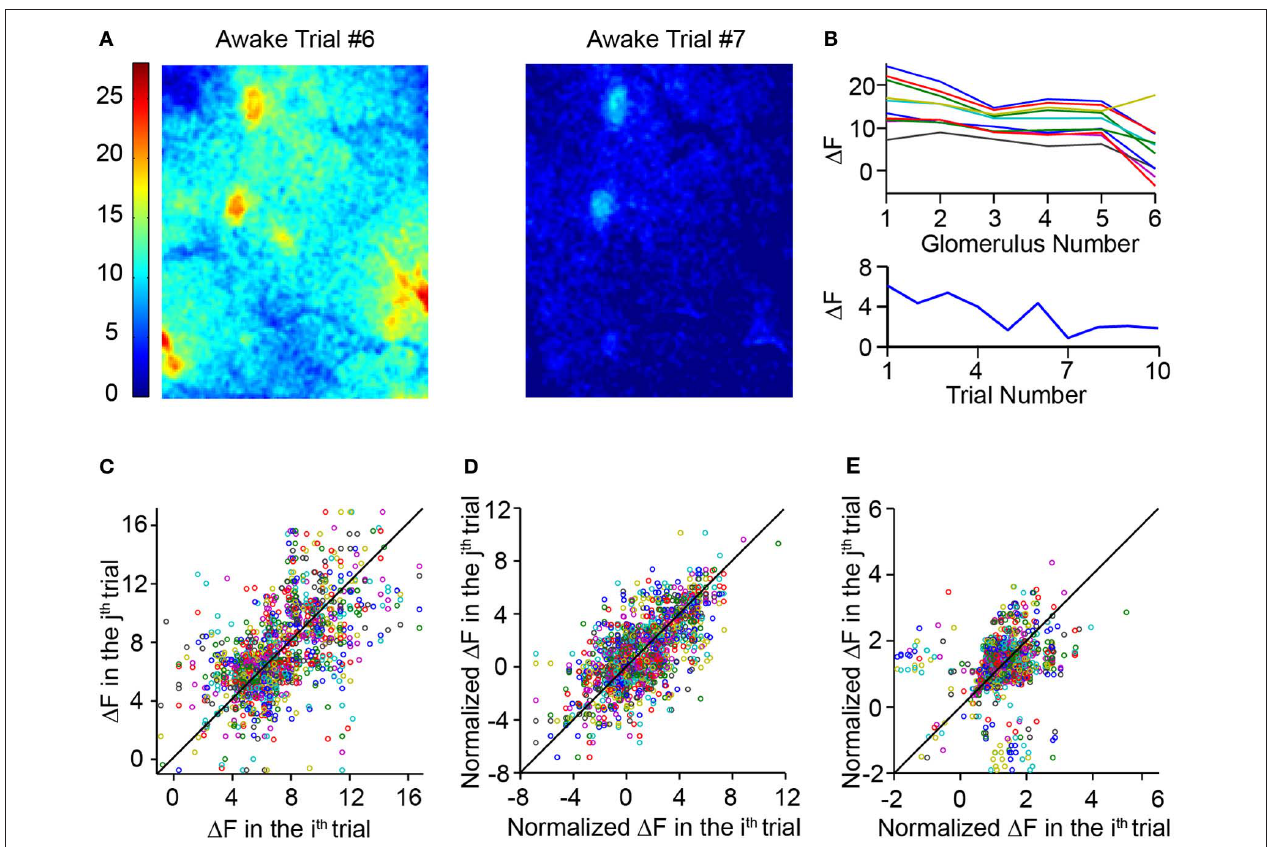
trials. While the average response decreases over the 10 trials, the fluctuation cannot be explained solely by habituation. (C) Scatterplot comparing the (cid:2) F of a glomerulus in a single trial to the (cid:2) F values of the same glomerulus in each other trial. (D) Scatterplot similar to c but comparing normalized (cid:2) F values. (cid:2) F was normalized by subtracting the average (cid:2) F value of the entire dorsal bulb. (E) Scatterplot comparing (cid:2) F values normalized by dividing (cid:2) F values by the whole dorsal bulb (cid:2)